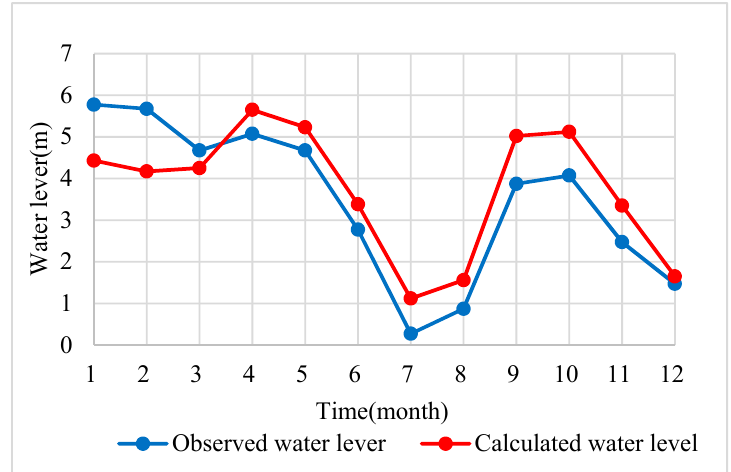
Figure 8. Dynamic fitting curve of groundwater level of Xixia well 1 in 2017.